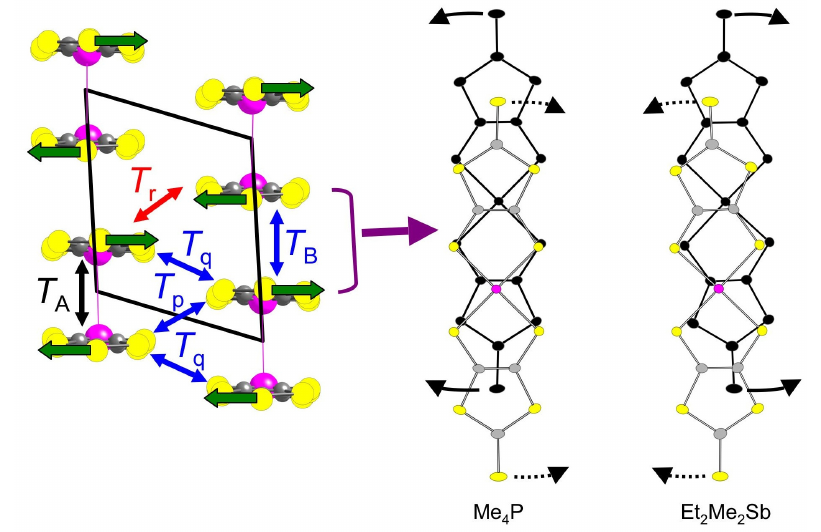
Figure 12. Relations between T